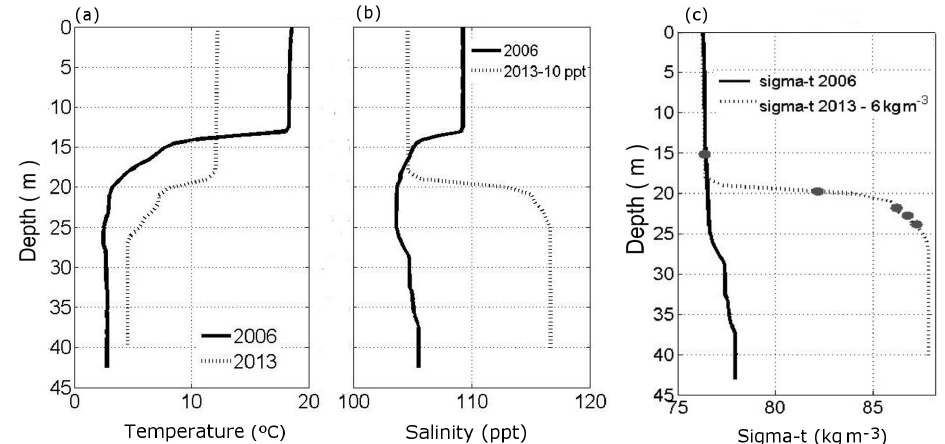
Figure 2. Characteristic profiles of (a) temperature, (b) salinity and (c) density during field expeditions in 2006 and 2013. Elongated dots on the 2013 density profile show the location of the temperature